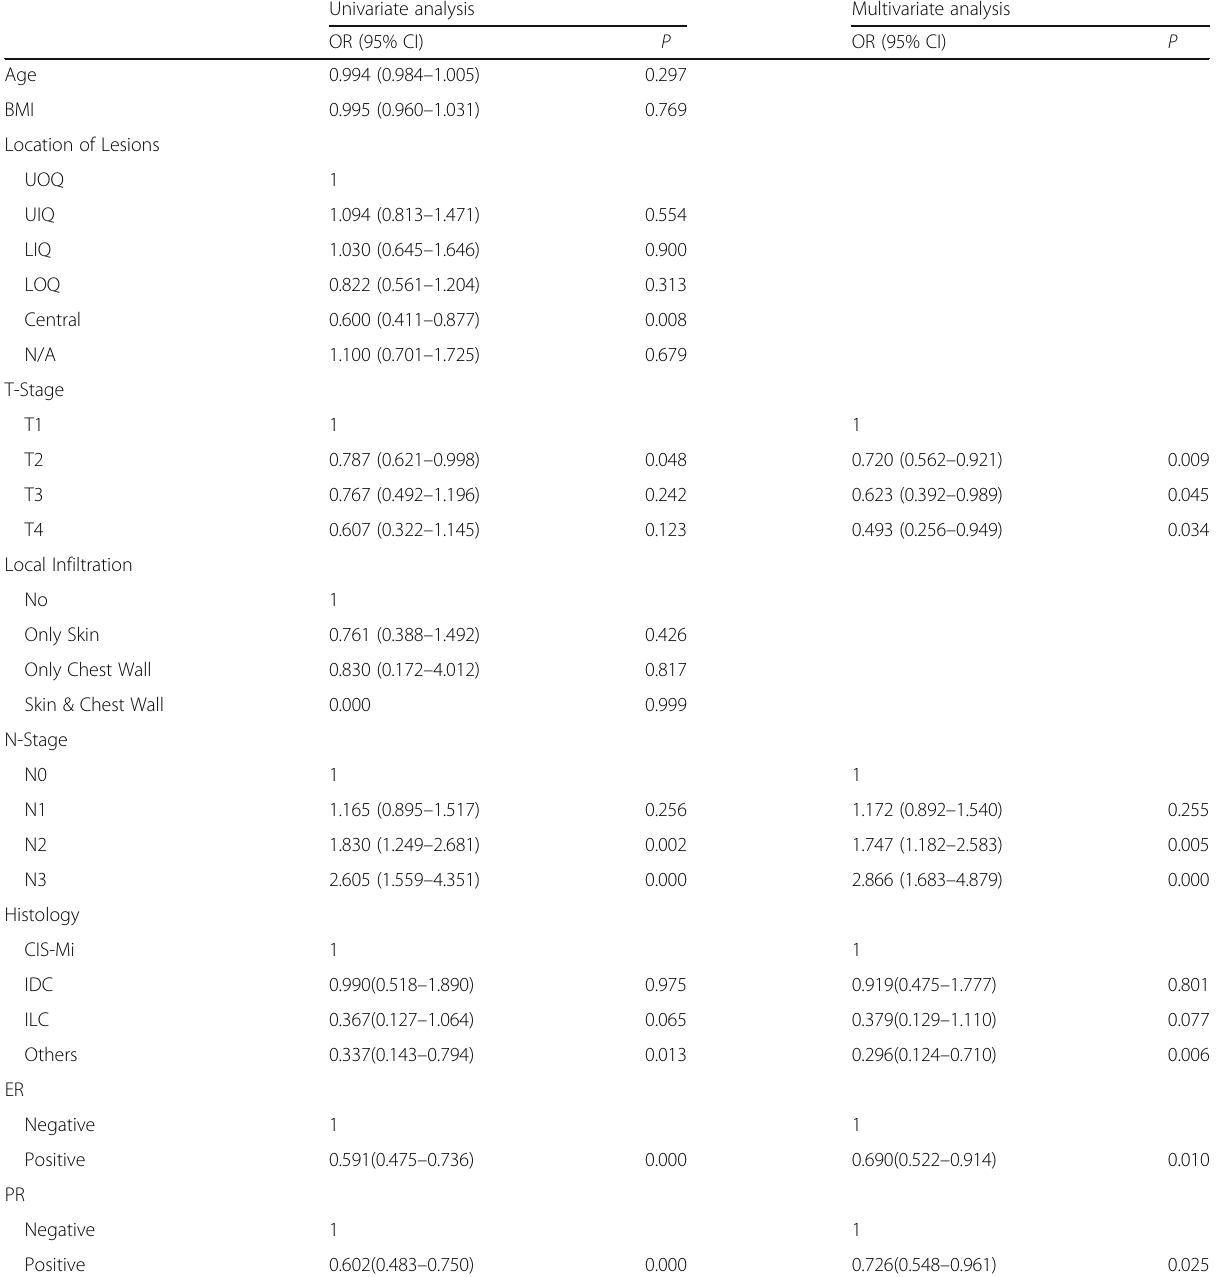
Table 2 Analysis of risk factors for HER-2 positivity